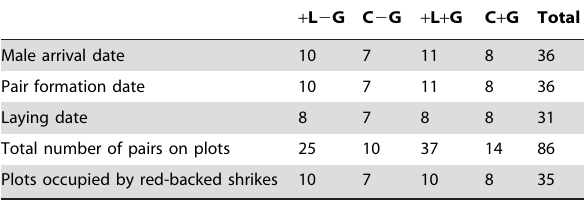
Table 1. Numbers of red-backed shrike pairs included into analyses for particular treatment plots (not all study plots were occupied by red-backed shrikes and there were also some minor losses during the breeding